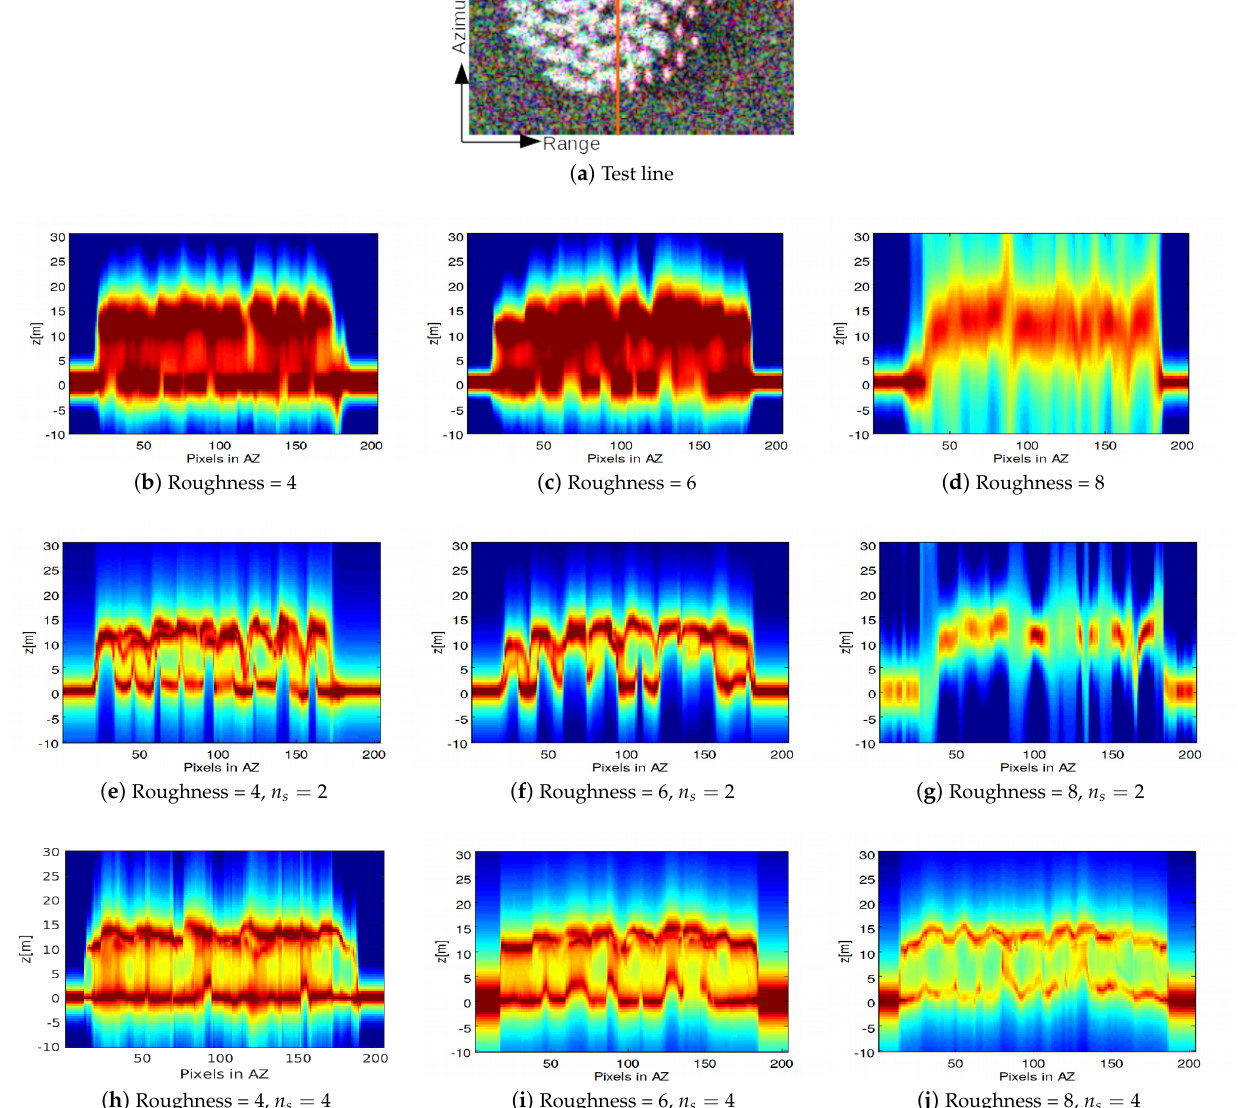
Figure 11. P-Capon and P-MUSIC tomograms with n s = 2 and n s = 4 over a test line for different ground roughness: P-Capon ( b – d ); and P-MUSIC ( e – j